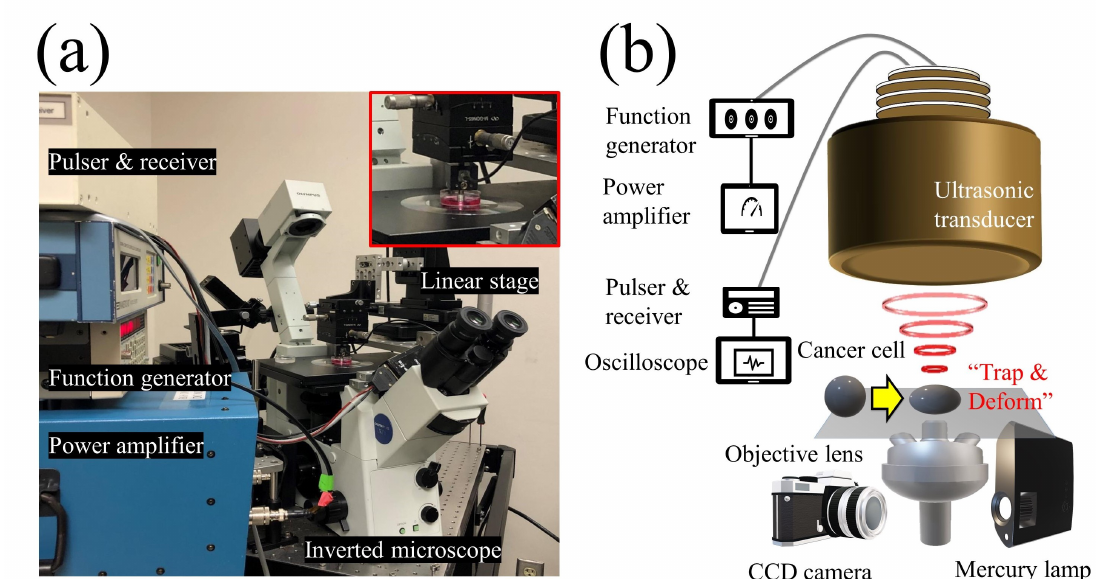
Figure 1. Schematic diagram of the experimental system. ( a ) Photograph of the experimental system. ( b ) The single-beam acoustic tweezers (SBAT) was driven at 50 MHz by sinusoidal bursts from a function generator amplified with a 50 dB amplifier. A single cell or a single sphere could be deformed by the